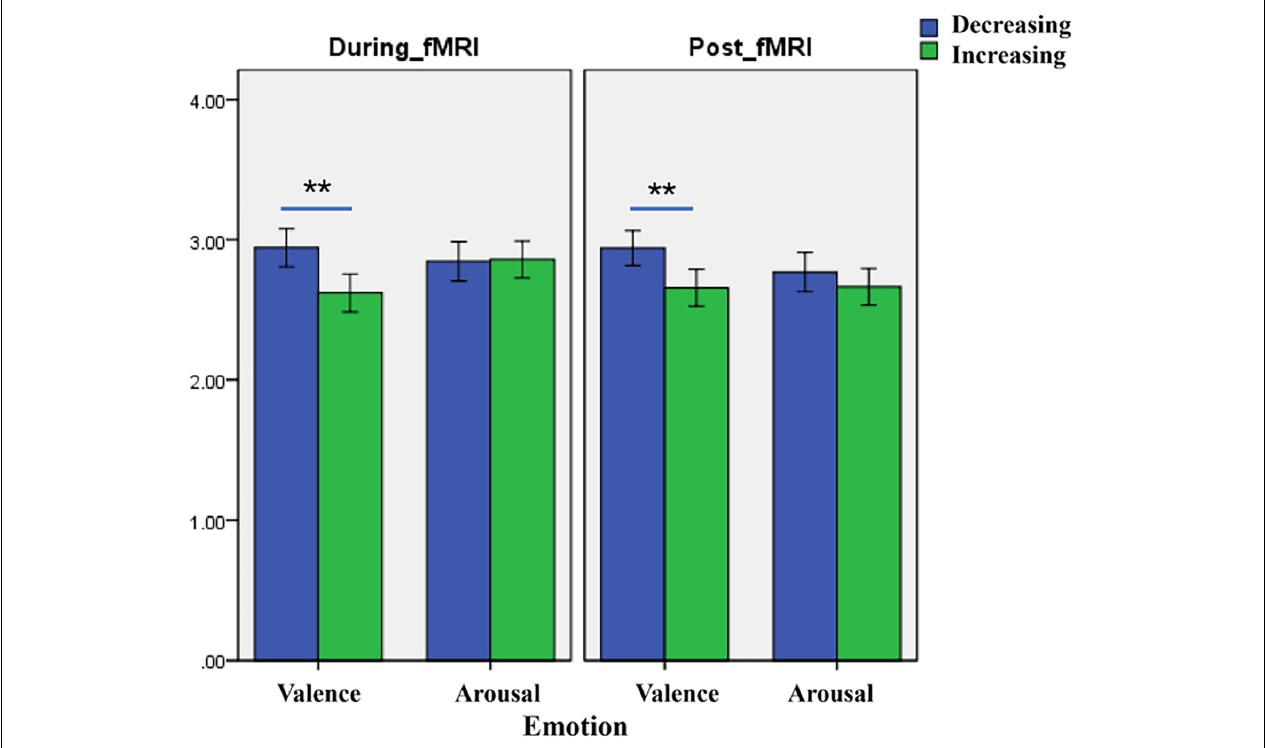
FIGURE 2 | The difference of valence between decreasing music and increasing music (** means p < 0 . 01), which presents a significant difference between the two groups of behavioral data and can occur 99%.